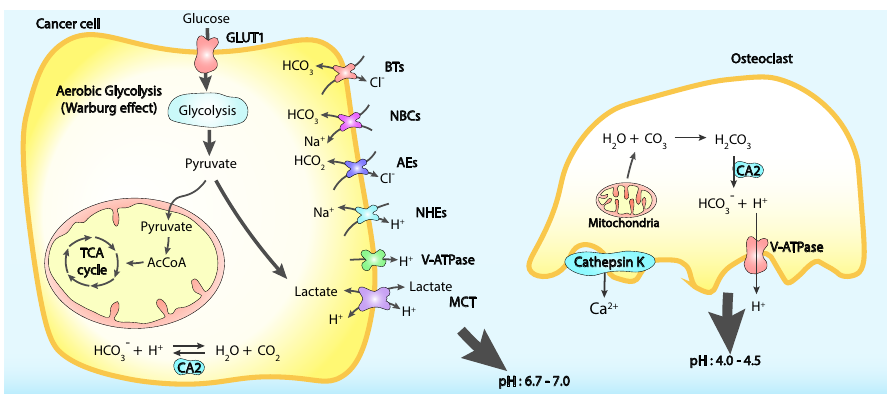
Figure 4. Mechanisms of extracellular acidification: Tumoural cells secrete H + ions and import HCO 3 − to counter the intracellular acidification resulting from the increased glycolysis (Warburg Effect). This actively regulated process involves many plasma membrane proteins like HCO 3 − transporters, co-transporters and exchangers, proton pupms and exchangers, and monocarboxylate transporters (MCT). At the same time osteoclasts actively secrete protons to degrade the minaralized bone matrix acidifying the bone extracellular environment. Bicarbonate transporters (BTs), sodium- bicarbonate co-transporters (NBCs). anions exchangers (AEs), sodium-hydrogen exchangers (NHEs), vacuolar proton-translocating ATPase (V-ATPase), carbonic anhydrase 2 (CA2), glucose transporter 1 (GLUT1). Adapted from